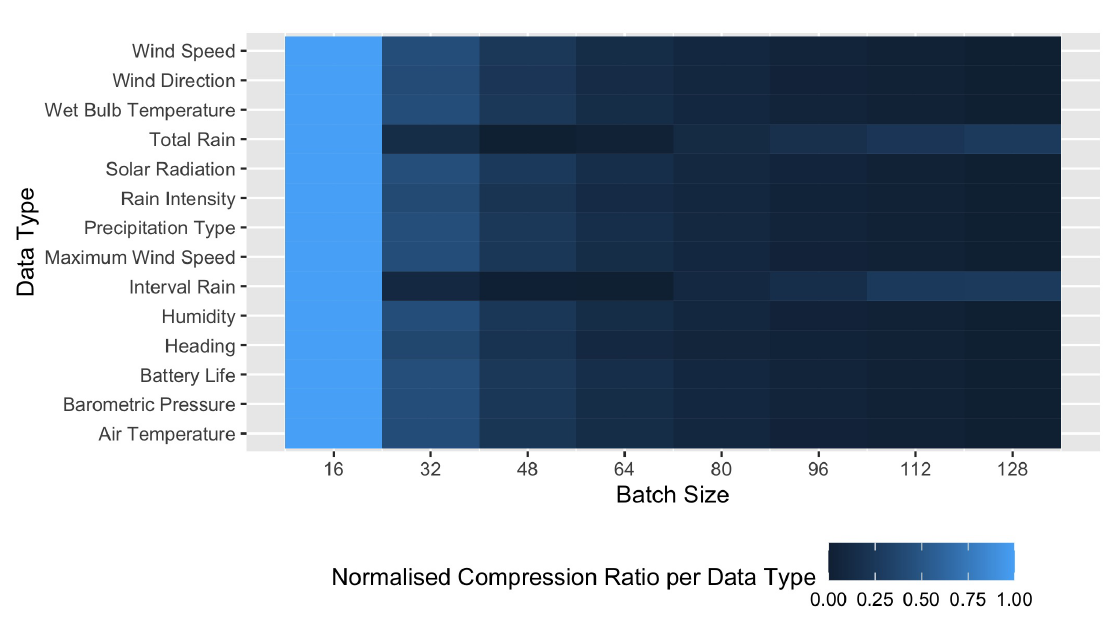
Figure 6. Normalised compression factor for each data type as the batch size